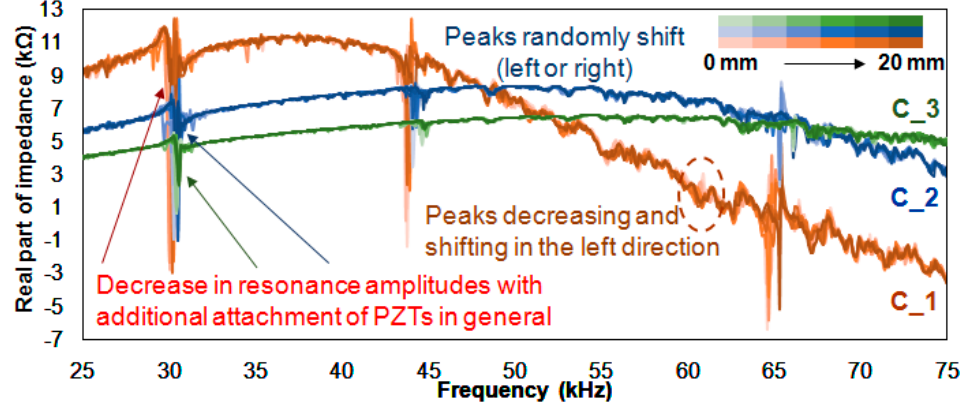
Figure 3. Impedance signatures for C_1, C_2 and C_3 experiment.